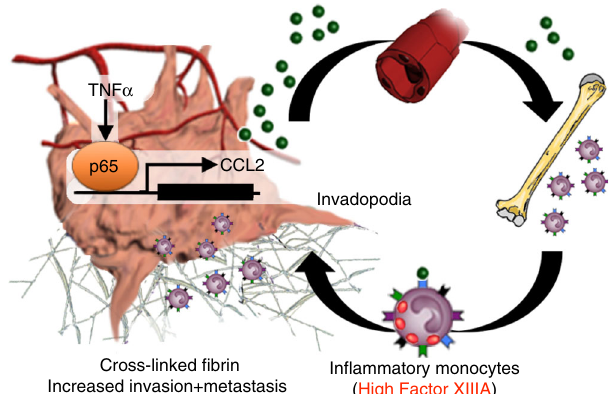
Fig. 8 Schematic of the ‘ IM-rich subset ’ of lung squamous carcinoma. TNF